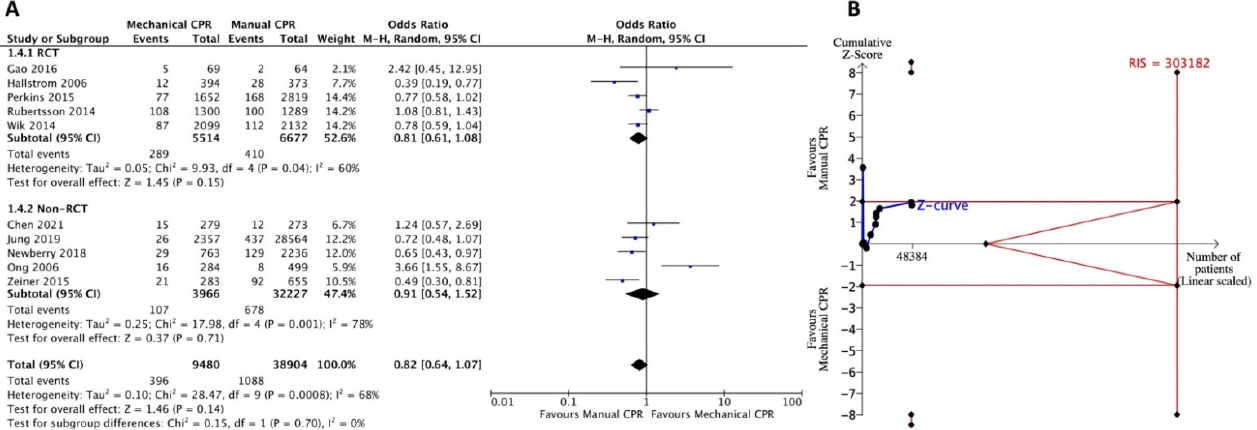
Figure 5. Forest plot ( A ) and trial sequential analysis ( B ) for survival to discharge with favorable neurologic status between mechanical CPR device and manual CPR. CPR: cardiopulmonary resuscitation; CI: confidence interval; RCT: randomized controlled trial; RIS: required information size.